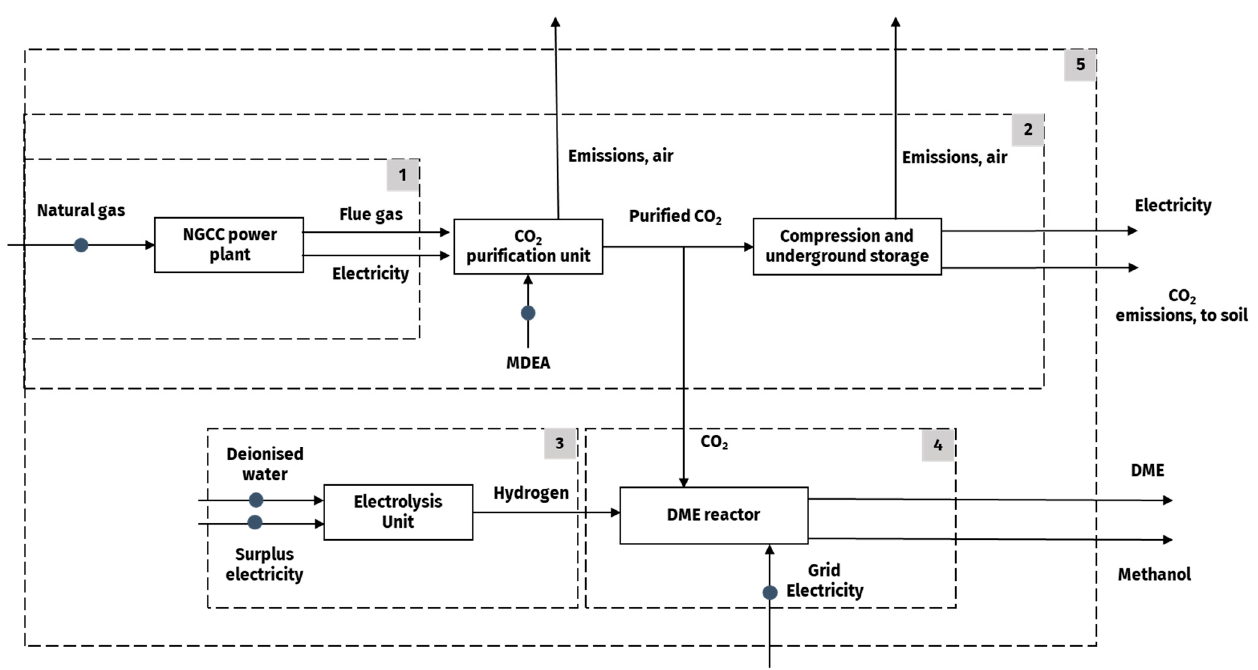
Figure 2. System boundaries.